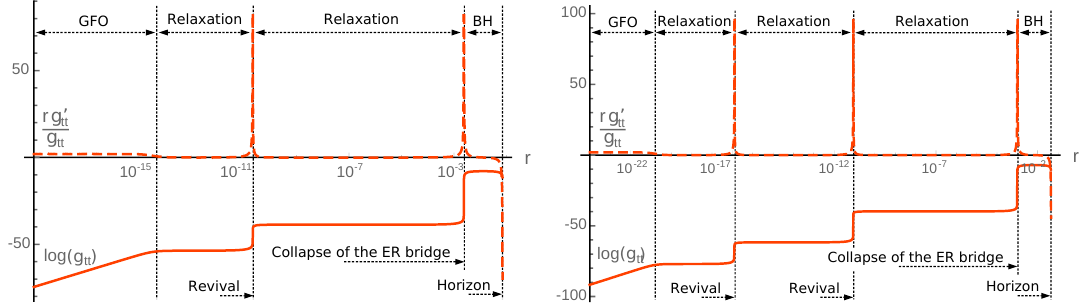
Figure 3 . Revivals: profiles of log g tt and rg 0 /g tt for two different solutions with q = 1 , α = 2 , m = tt 1 , h = 0 . 833 , N = 0 . 788 . The one on the left corresponds to h 0 h h while that on the right to h 0 = , 0 . 957 , φ 0 . 173 , r = 0 . 046 h h h